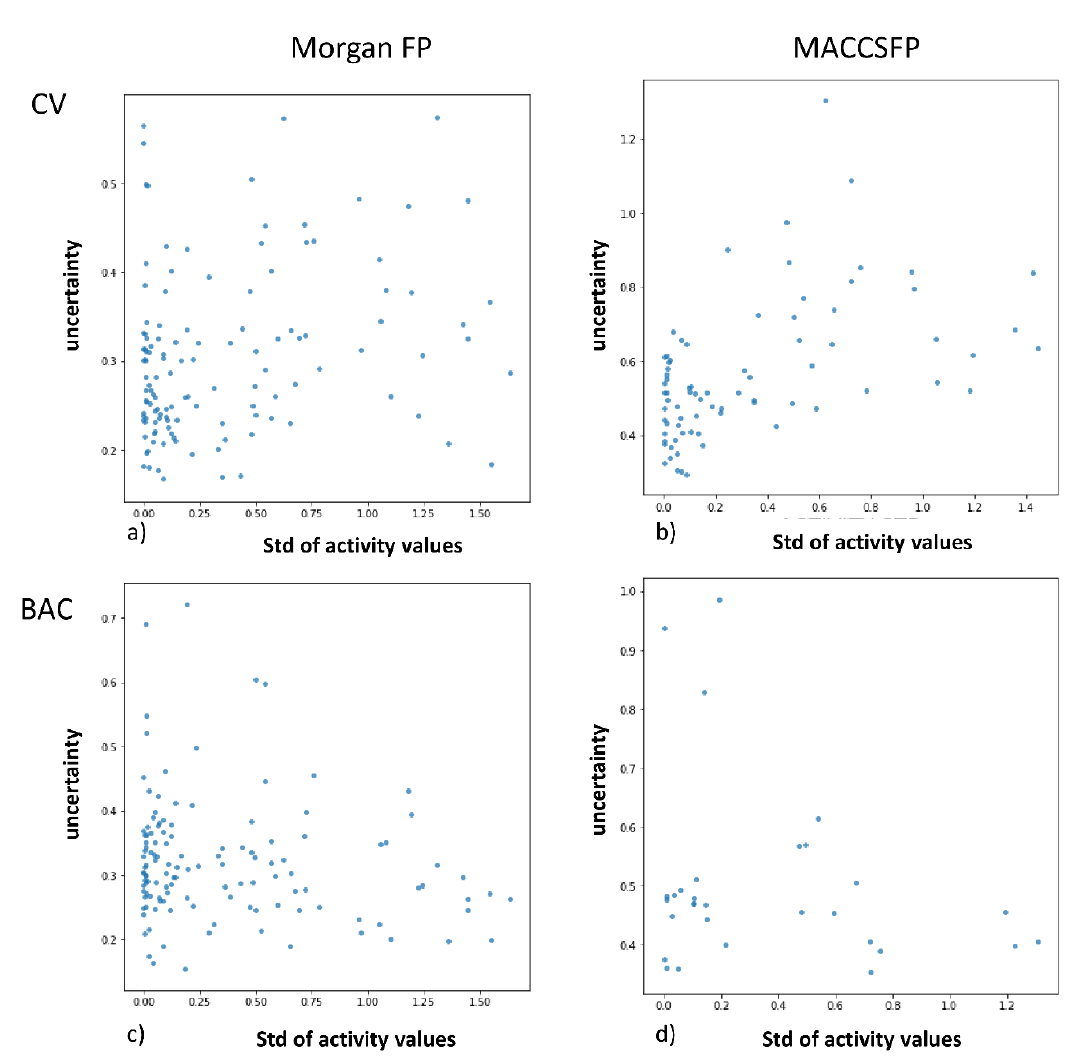
Figure 3. Analysis of dependency between prediction uncertainty and standard deviation of activity values provided for particular compound in the ChEMBL database for adenosine A 1 ligands. ( a ) for Morgan FP in CV experiments; ( b ) for MACCFP in CV experiments; ( c ) for Morgan FP in BAC experiments; ( d ) for Morgan FP in BAC experiments .